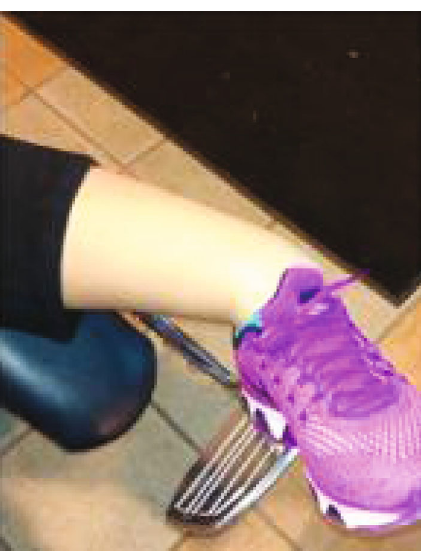
Figure 1: Gross internal rotation and inversion injury of the left